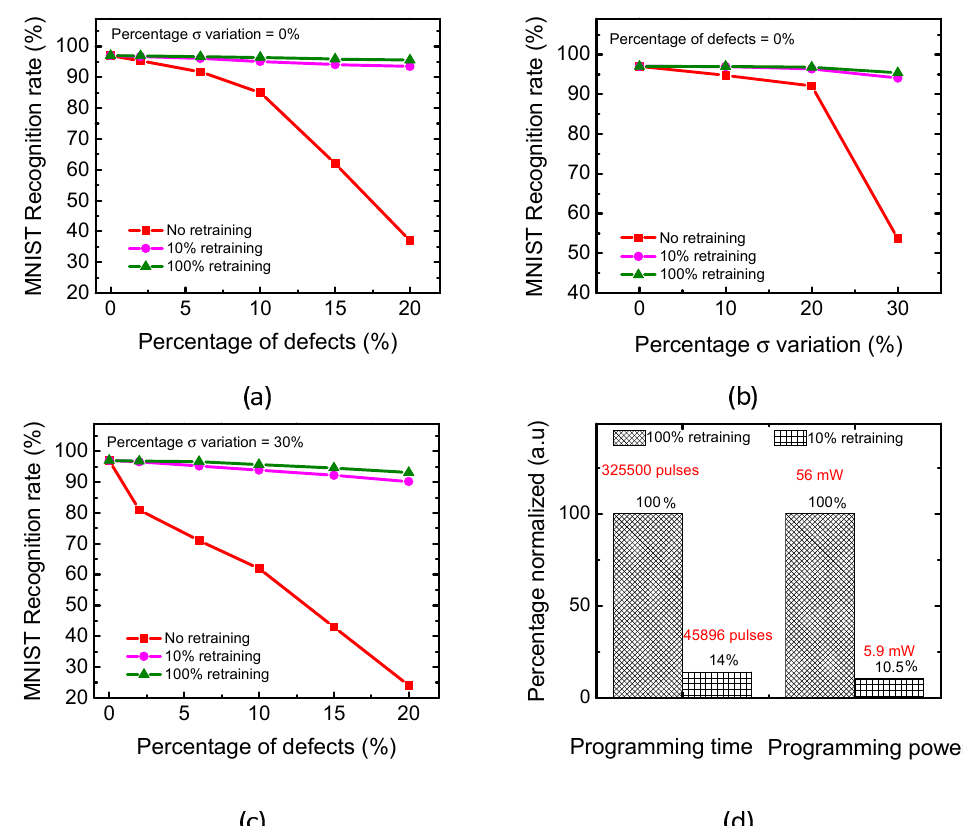
Figure 5. ( a ) The simulated MNIST recognition rates of the 0%, 10%, and 100% retraining with varying the percentage of stuck defects from 0% to 20% ( b ) the simulated MNIST recognition rates of the 0%, 10%, and 100% retraining with varying the percentage σ variation in memristor’s conductance ( c ) the simulated MNIST recognition rates considering both the stuck defects and percentage σ variation in weights ( d ) the programming time and power of the 10% and 100% retraining. In the programming time, we compared the total number of programming pulses between the 10% and 100% retraining.